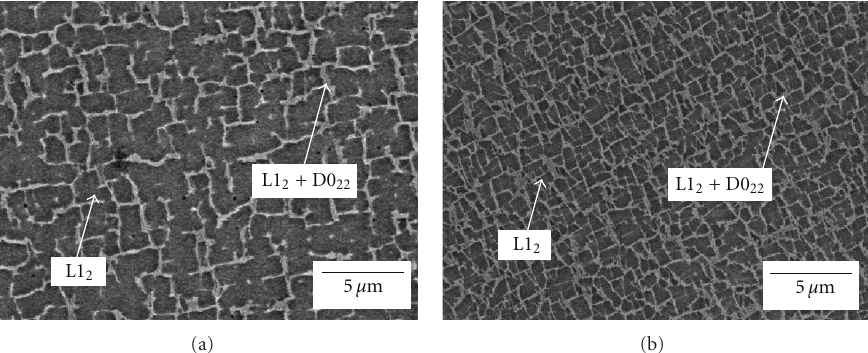
Figure 1: Microstructures of Ni 3 Al/Ni 3 V two-phase intermetallic compounds: (a) type 1 and (b) type 2 before experiments and after galvanostatic